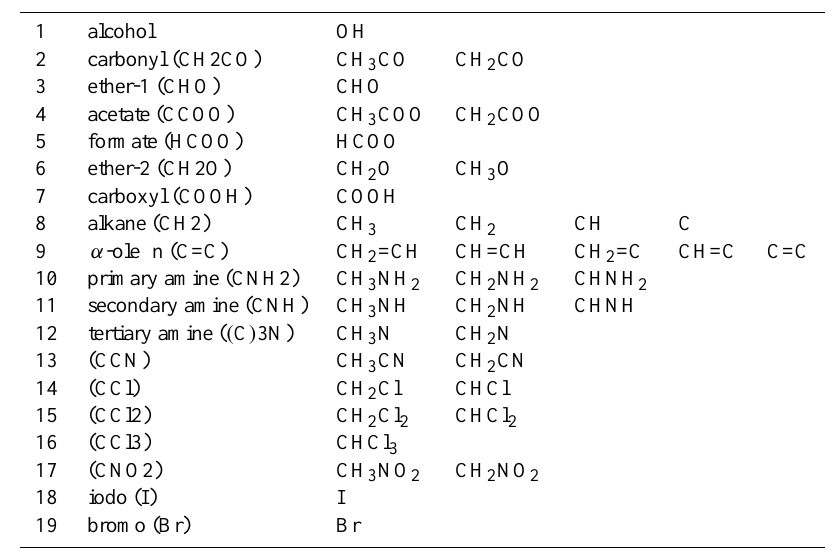
Table 1. Functional groups used in the initialisations and hence throughout the sensitivity simulations.